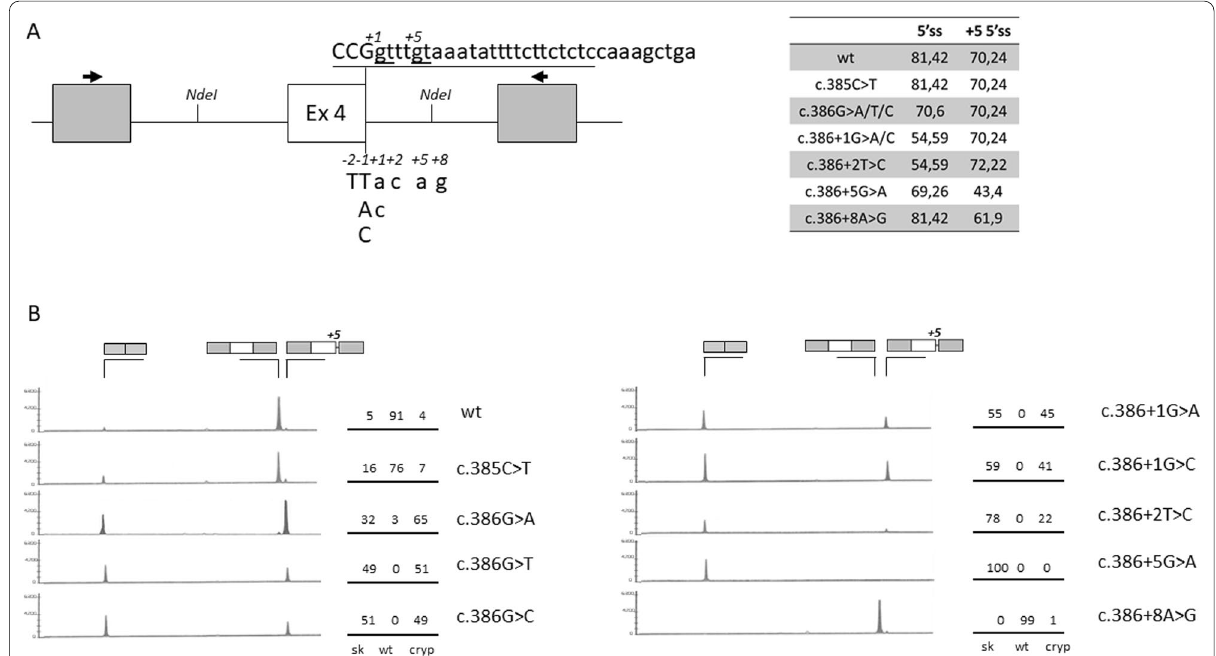
Fig. 4 The interplay between the authentic and the cryptic 5 ′ ss governs the pathogenic effect of natural OTC mutations. A Schematic representation of the human OTC exon 4 genomic sequence cloned as minigene in the pTB vector within the Nde I sites. Exonic and intronic sequences are represented by boxes and lines, respectively. Primers (arrows) used to perform the RT-PCR are indicated on top. The sequences, with exonic and intronic nucleotides in upper and lower cases respectively, report (i) the authentic 5 ′ ss with the positions of the investigated changes detailed below, and (ii) the cryptic 5 ′ ss. Both 5 ′ ss are underlined. The table reports the scores of the 5 ′ ss in the normal sequence and in the presence of different OTC nucleotide changes found in OTCD patients. B OTC h splicing patterns evaluated by RT-PCR and denaturing capillary electrophoresis on RNA isolated from HepG2 transiently transfected with the wild-type (wt) minigene or harboring the indicated nucleotide changes. The schematic representation of transcripts (with exons not in scale) is reported on top. Numbers on the right report the relative percentage of